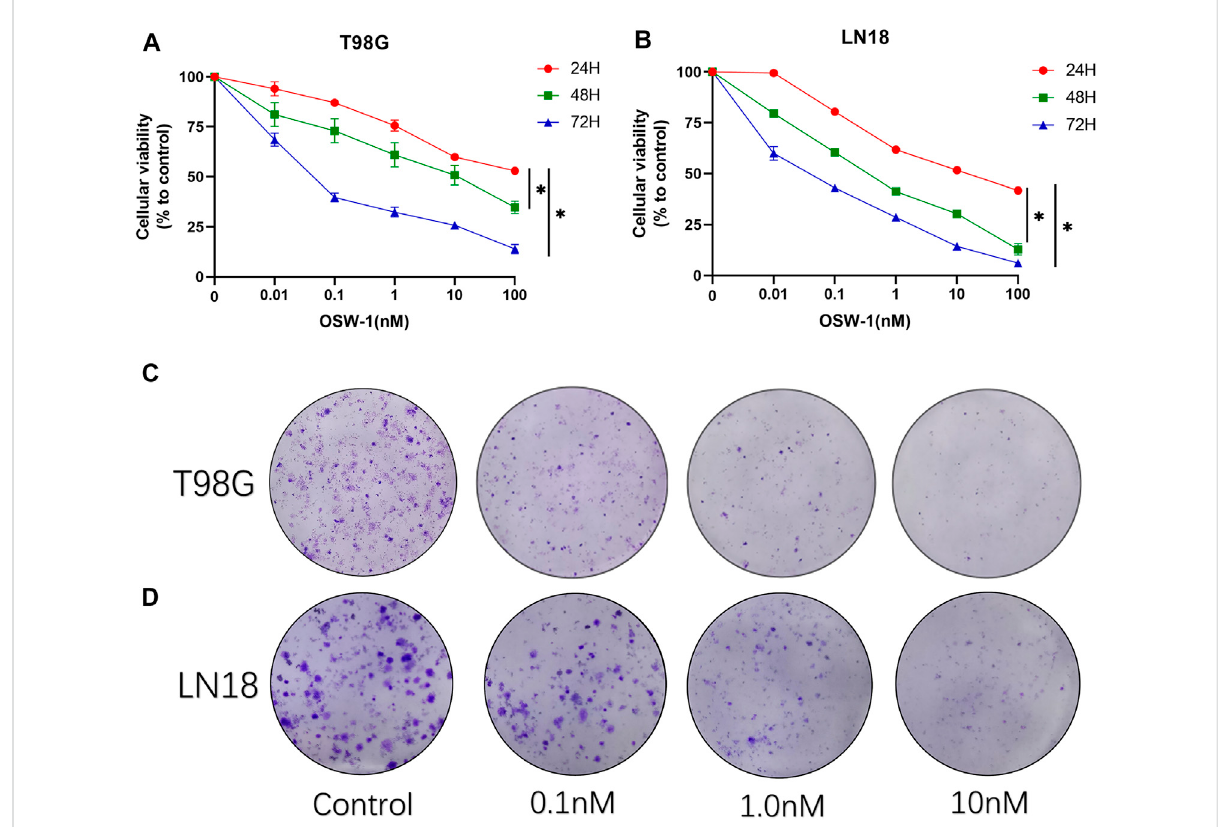
FIGURE 4 OSW-1 inhibited cell viability and proliferation of glioma cells (A,B) CCK-8 assay detected the viability of cells treated with different concentrationsofOSW-1for24,48,and72 h.TheresultsshowedthatOSW-1inhibitedcellularviabilityinatime-anddose-dependentmanner (C,D) Clone formation experiments showed that clone numbers of glioma cells decreased gradually with increasing concentrations of OSW-1. * p < 0.05, compared to the control